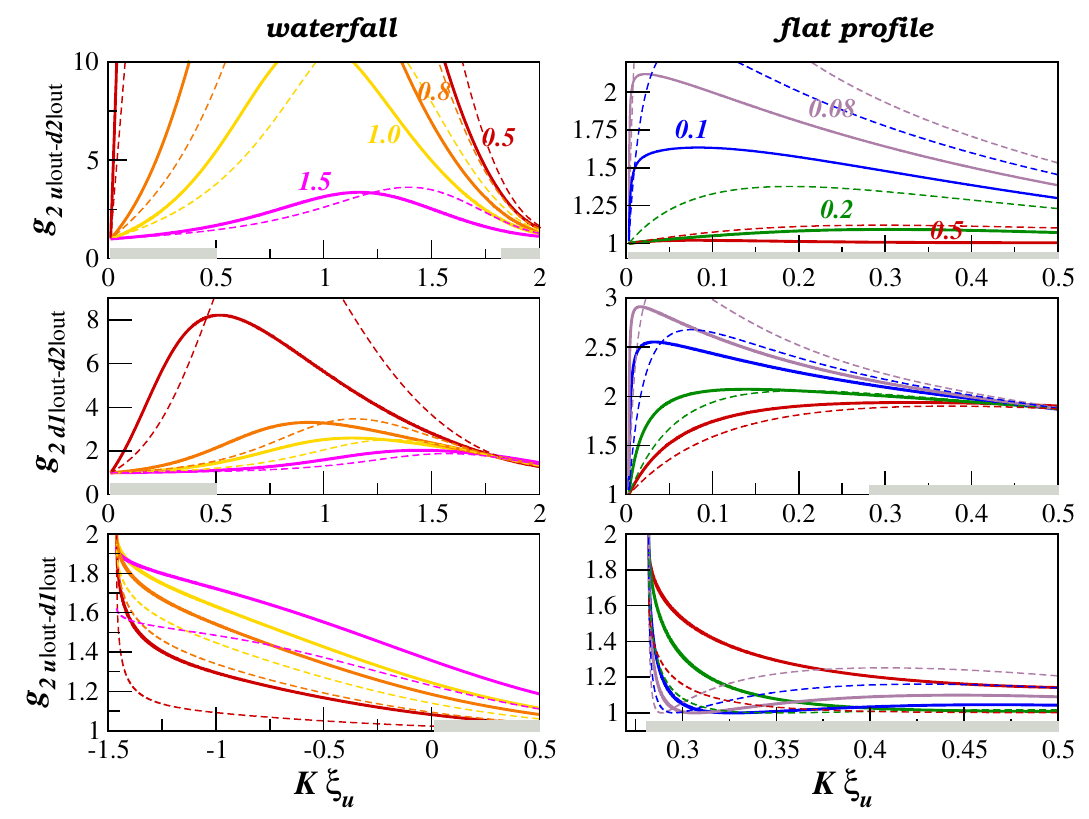
Figure 6: Normalized correlation functions in the waterfall configuration (left plots) and flat = 0.5 and M = 4 in both cases. The vertical arrangement of the profile (right plots). M u d different plots corresponds to the intensity of the correlation signal along the u | out − d 2 | out, d 1 | out − d 2 | out and u | out − d 1 | out correlation lines identified in Fig. 4. The Cauchy-Schwarz inequality is violated when g is larger than 2. In each plot the different lines correspond to 2 different temperatures, the values of which are indicated in units of mc 2 . The thick solid (thin u dashed) lines correspond to a situation where the system is at thermal equilibrium in the frame of the condensate (of the obstacle) before the formation of the sonic horizon. The shaded zone on the abscissa axis represent the region of overlap of the momenta of the outgoing channels, see the discussion at the end of Sec.